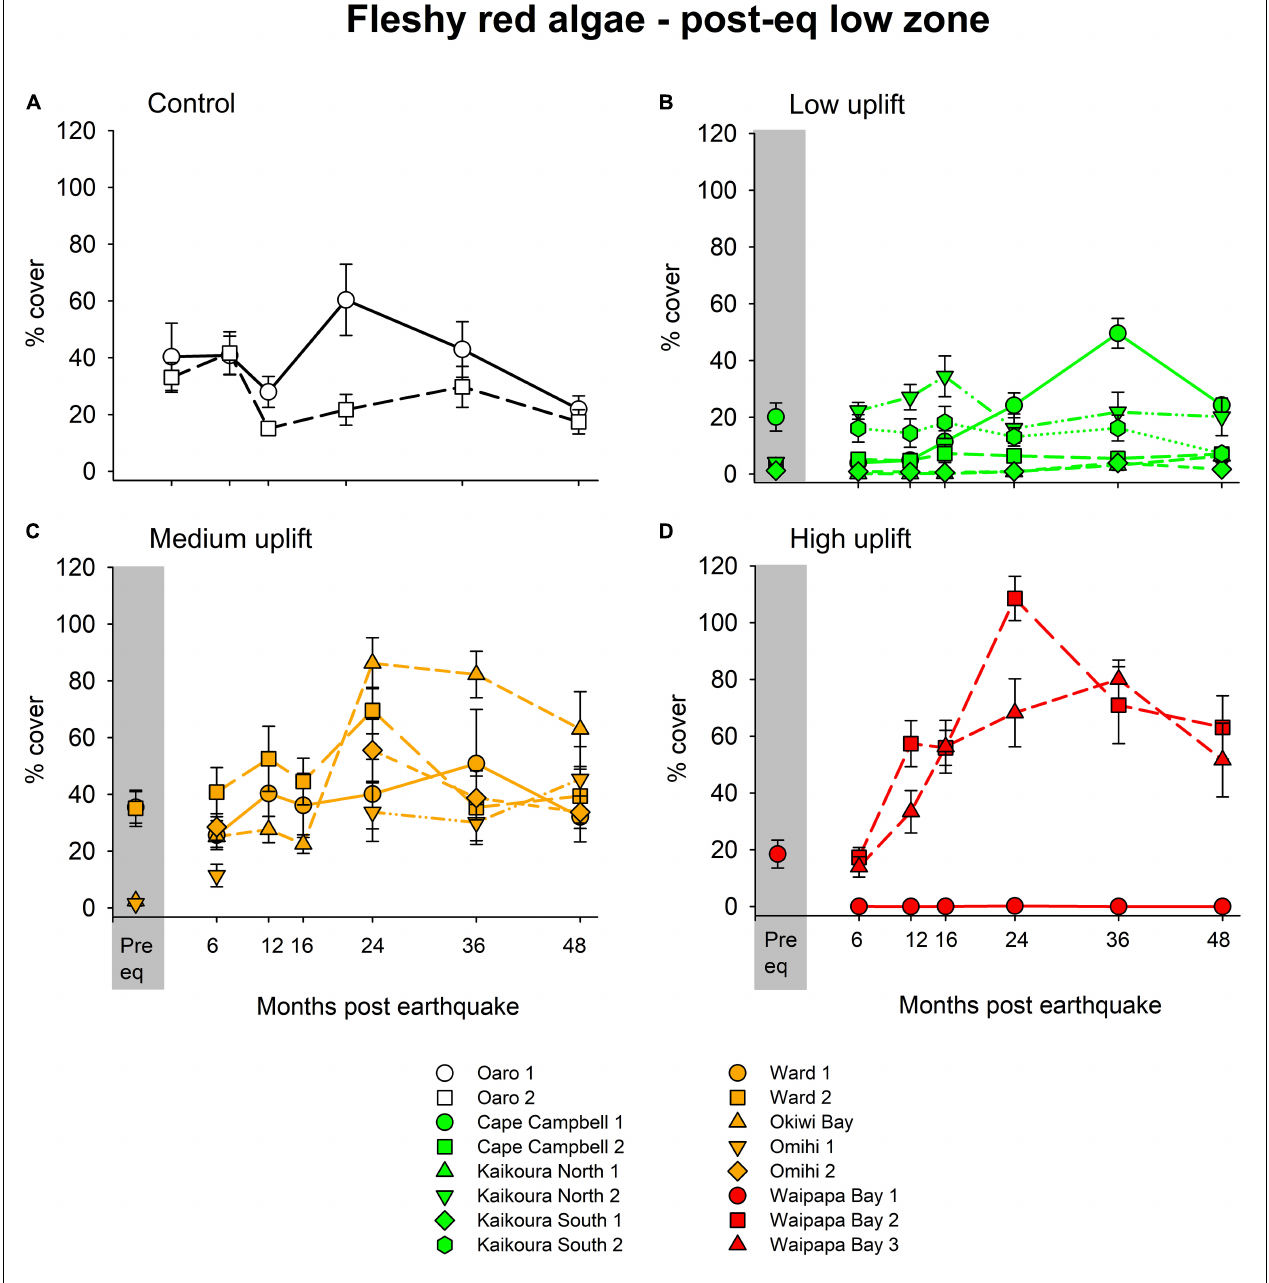
FIGURE 6 | The percentage cover ( ± SE) of fleshy red algae at each site within control (A) , low (B) , medium (C) and high (D) uplift areas. Note the decline at 12 months, due to a severe heat wave. For the sites sampled in November 2016, the average abundance of large brown algae in the pre-earthquake low zone is displayed in the gray